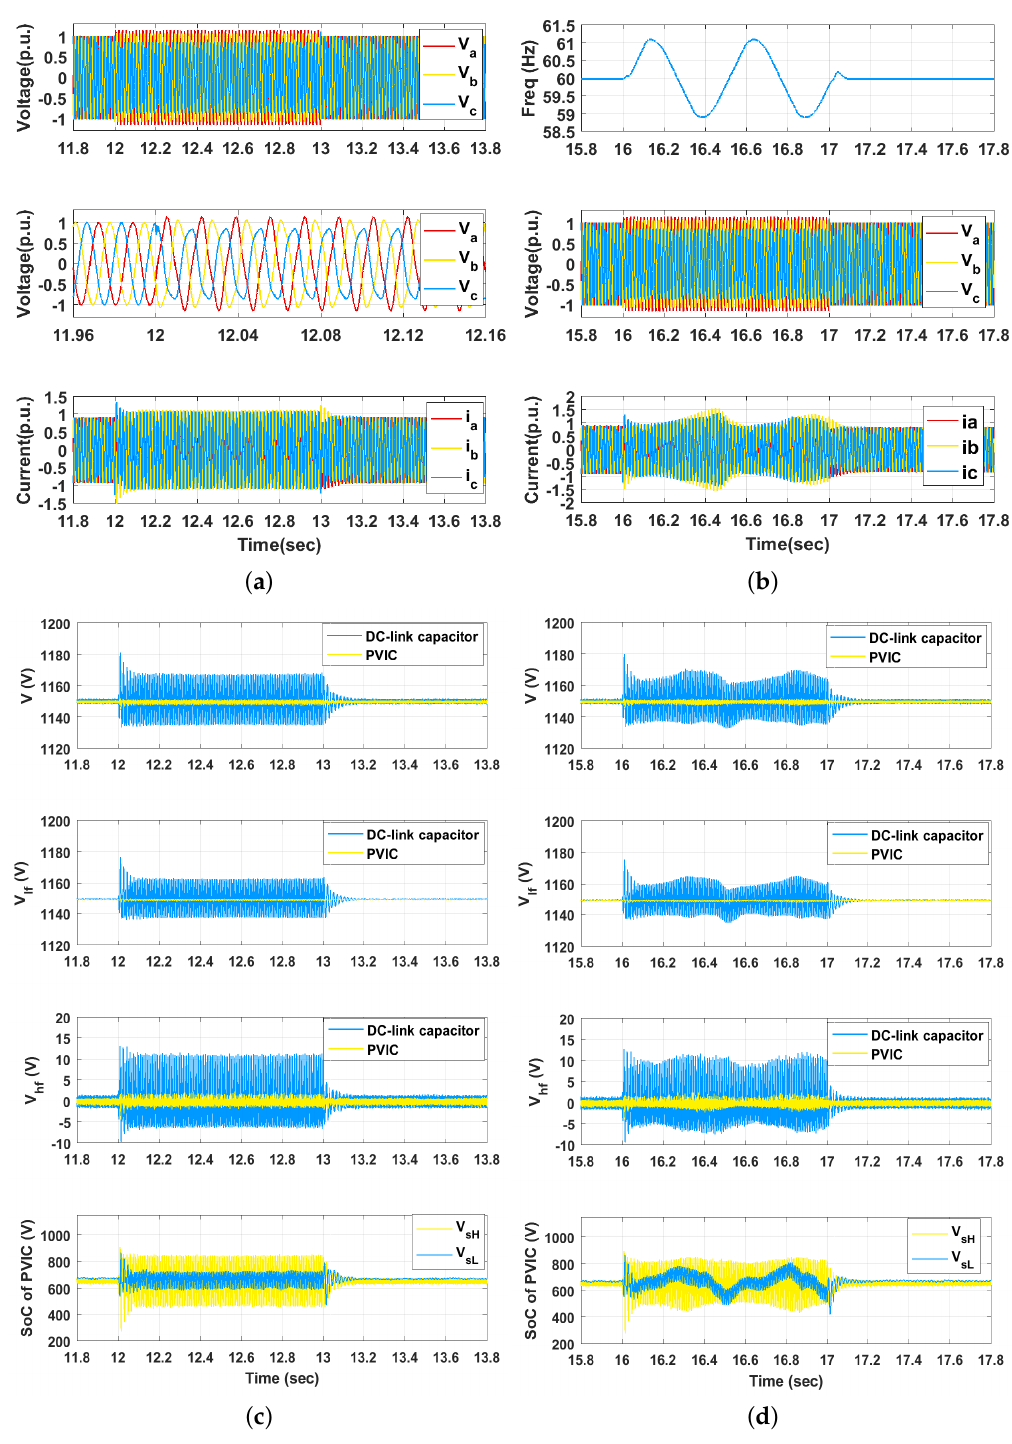
Figure 8. ( a ) shows the three-phase grid voltage and current when there is negative sequence 1st order harmonic (with magnitude of 0.1 p.u.) and negative sequence 3rd order harmonic (with magnitude of 0.1 p.u. and phase shift of 35 ◦ ) injected; ( b ) demonstrates the frequency variation, three-phase grid voltage and current when the situations in Figure 7a and ( a ) both occur; ( c ) describes voltage filtering performance ( V , V lf , V hf ) of DC-link capacitor and PVIC, and PVIC’s state of charge ( V s under the grid conditions of ( a ); ( d ) displays voltage filtering performance ( V , V lf , V hf ) of the DC-link capacitor and PVIC, and PVIC’s state of charge ( V s